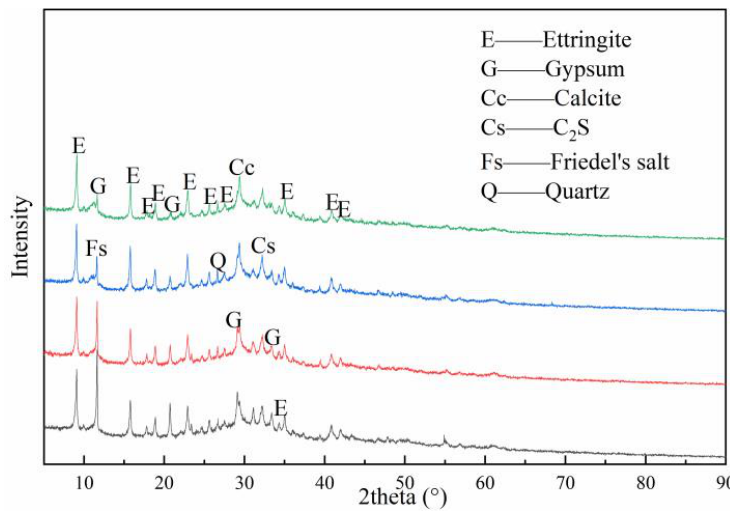
Figure 6. XRD patterns of the paste with different ASR-to-DG ratios at 180 days.